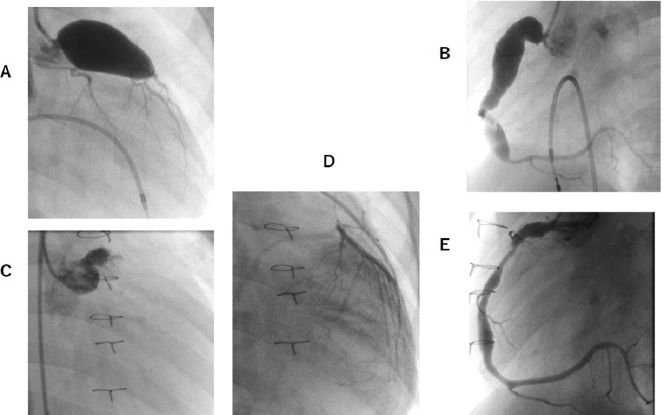
Figure 2. CAG of patient F before and after 18 months of CABG and RCA downsizing reconstruction. ( A , B ) are before CABG. And ( C , D , E ) are after 18 months of CABG. ( A ), LCA angiography. Giant aneurysm 16.5 × 31 mm were located. No stenotic lesion was observed; ( B ), RCA angiography. Giant aneurysm RCA, sized 10.0 × 37 mm, and medium aneurysm, sized 7.0 × 17 mm, were observed; ( C ), LCA angiography. LCA was occluded. LCx showed segmental stenosis after this; ( D ), LITA angiography. LITA–LAD bypass patency was good. ( E ); RCA angiography. The shape of RCA became good after downsizing reconstruction. Wash-out of the contrast medium became